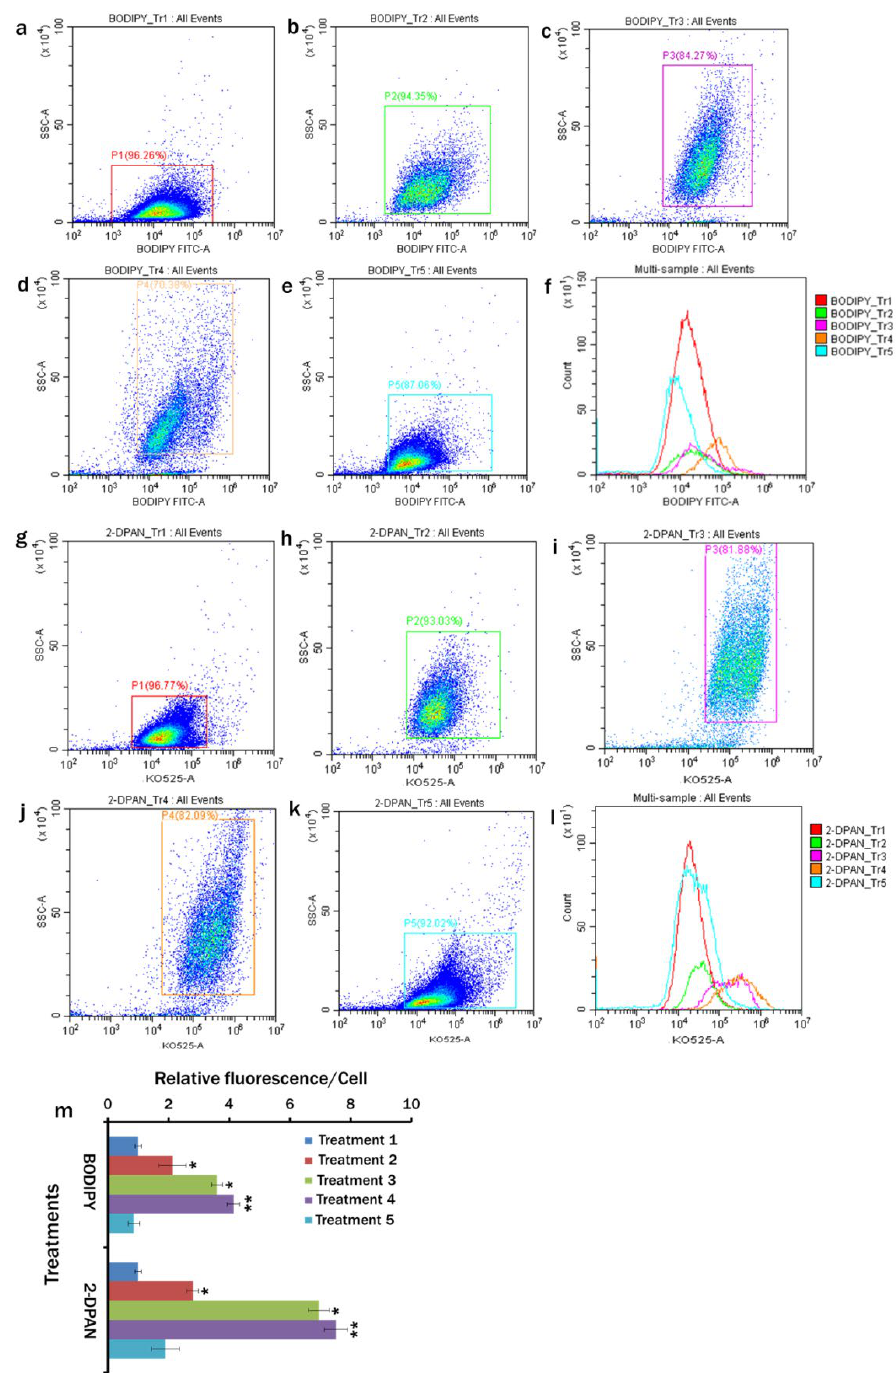
Figure 4. Flow cytometry measurements for lipid in Chlamydomonas reinhardtii cells in different treatments labelled with BODIPY™ 505/515 and AIE probe, 2-DPAN. ( a – e ) Flow cytogram of FITC-A vs. SSC-A for BODIPY fluorescence in different treatments; ( g – k ) Flow cytogram of KO525-A vs. SSC-A for 2-DPAN fluorescence. Cells were cultured in Treatment 1: modified Woods Hole (MBL) medium; Treatment 2: MBL, ( − ) N 2 ; Treatment 3: MBL, ( − ) N 2 , ( − ) Ca 2+ ; Treatment 4: MBL, ( − ) N 2 , ( − ) Ca 2+ , (+) sodium acetate (2.0 g/L) (24 h light); and Treatment 5: MCM, ( − ) N 2 , ( − ) Ca 2+ , (+) sodium acetate (2.0 g/L) (24 h Dark) conditions. Histogram of BODIPY™ 505/515 ( f ) and 2-DPAN ( l ) fluorescence for cells. ( m ) Relative fluorescence of BODIPY™ 505/515 and 2-DPAN / cell for different treatments. Values are relative to the control condition of Treatment 1. Averages shown as mean ± SE; * p < 0.05; ** p < 0.01. All plots are in the logarithmic scale for both